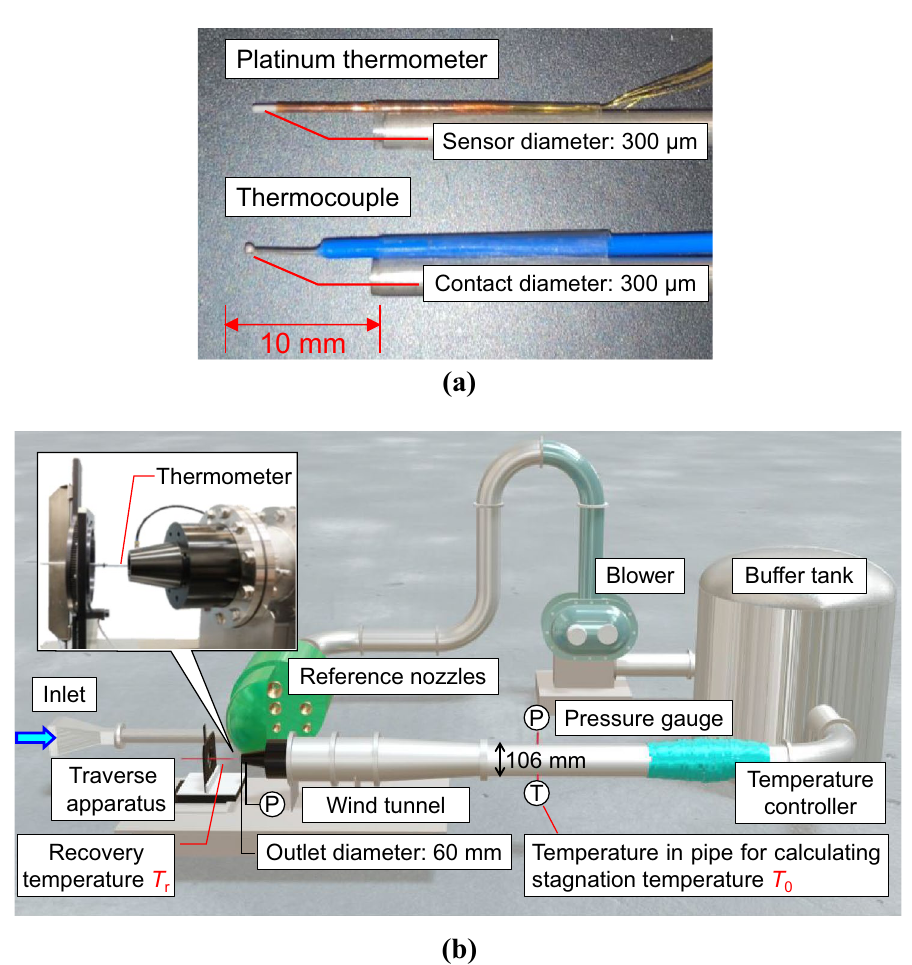
Figure 2. Conceptual diagram of the comparison experiment with reference velocity. ( a ) Thermometers for measuring the recovery temperature. The contact diameter of the thermocouple is approximately 300 μm. The sensor diameter of the platinum thermometer is approximately 300 μm, and sensor length is approximately 1.5 mm. ( b ) Conceptual diagram of test section. The reference velocity was derived by dividing the flow rate of the reference nozzles installed upstream of the test section using the cross-sectional area of the wind tunnel outlet. The reference nozzles can generate a constant flow rate because the flow velocity at the throat with the smallest cross-sectional area becomes equal to the speed of sound when a differential pressure of a certain level or more is applied by the blower. The thermocouple or platinum thermometer used to measure the flow velocity (recovery temperature) is attached to the traverse apparatus at the downstream side of the wind tunnel; the measured value by RTA is compared with the value of the reference